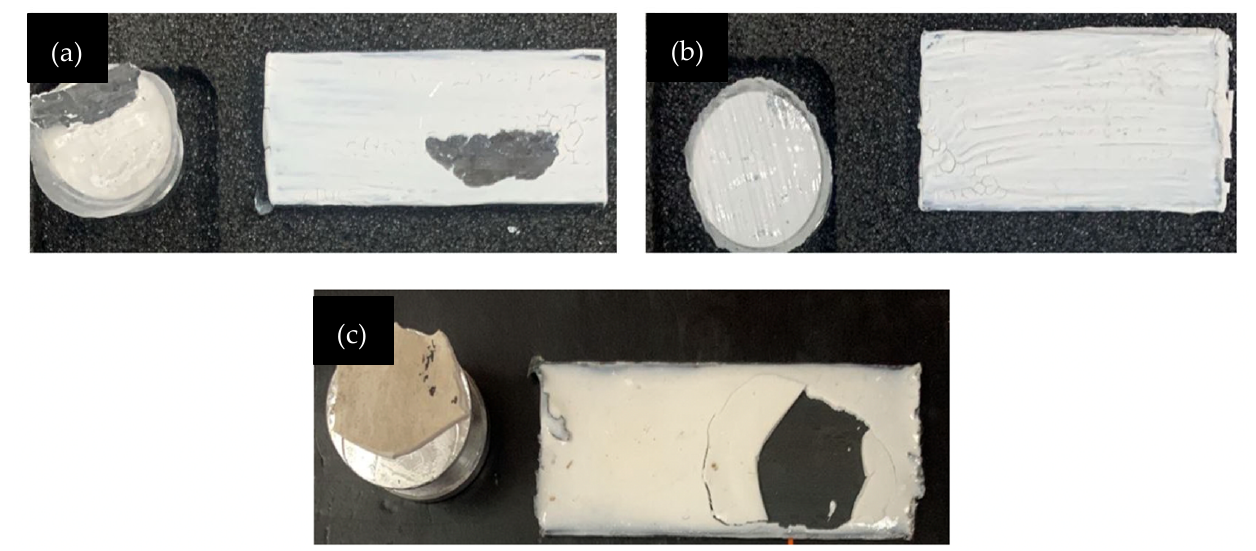
Figure 4. Adhesion strength of metakaolin geopolymer coating with various S/L ratios. Figure 5 demonstrated the metakaolin geopolymer ‐ coated sample with failure at S/L ratio of 0.6 for GP, GPTiO 2 Zn0.5, and GPTiO 2 Zn0.9. Coating samples with the highest and lowest adhesion strength together with GP as control sample were analyzed to learn which factors contributed to their respective performances.